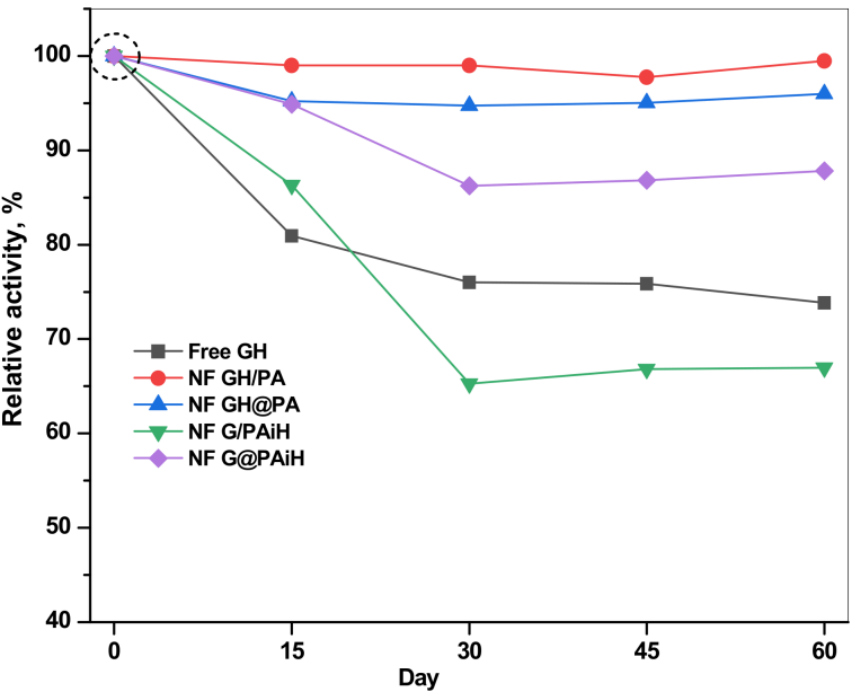
Figure 14. Storage stability of the PANF and free GH complexes at 4 °C, PBS. For each catalytic system the initial activity of the freshly prepared system is taken as 100%. For the absolute values of the initial activities see Table 1, column 4 (specific activity in µkatal·L −1 ).